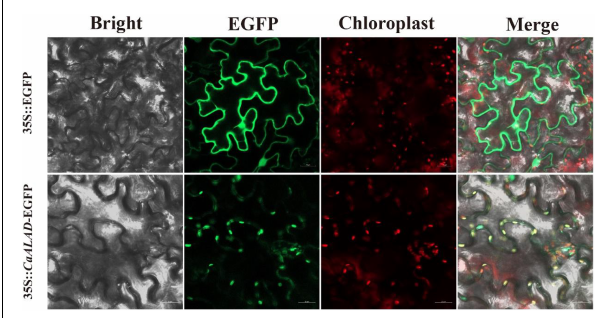
FIGURE 2 | Subcellular localization of CaALAD in N. benthamiana leaf cells. Fluorescence microscopy of the 35S: CaALAD -EGFP and 35S:EGFP (control) plasmids. Scale bars = 20 µ m.